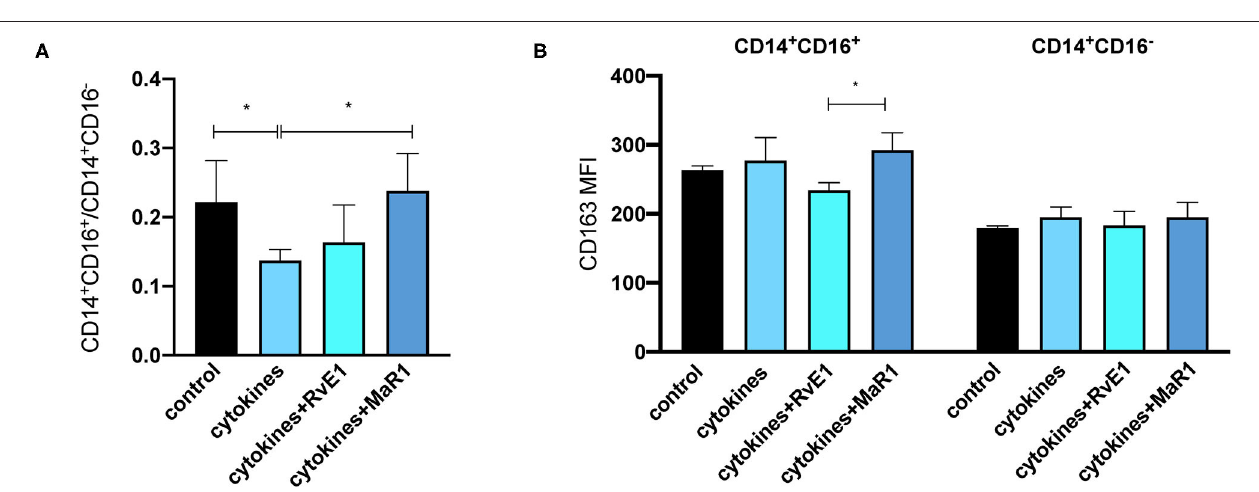
FIGURE 6 | Impact of MaR1 on the resolution of the inflammation. We then challenged PBMCs with the conditioned medium (CM) from pPDLSCs that received the cytokines and/or SPMs treatment. CM from the cytokine groups significantly reduced the CD14 + CD16 + /CD14 + CD16 − ratio. CM from the cytokines and MaR1 group restored the ratio to baseline (control without cytokines or SPMs (A) . This figure was a composite from two independent experiments. CD14 + CD16 + cells expressed more CD163 compared to CD14 + CD16 − cells. In CD14 + CD16 + cells, cytokines plus MaR1 had the highest CD163 expression (B) .* p <